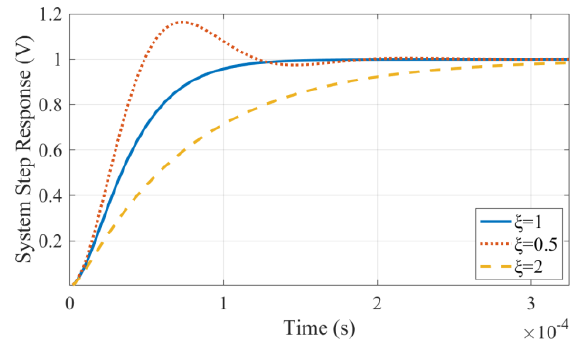
Figure 4. Comparison of the step response of the coil sensor under different damping conditions.